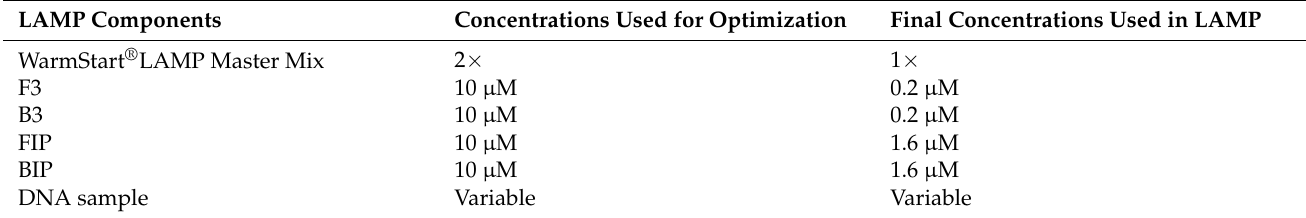
Table 3. Optimized LAMP components for the detection of T. japonensis.